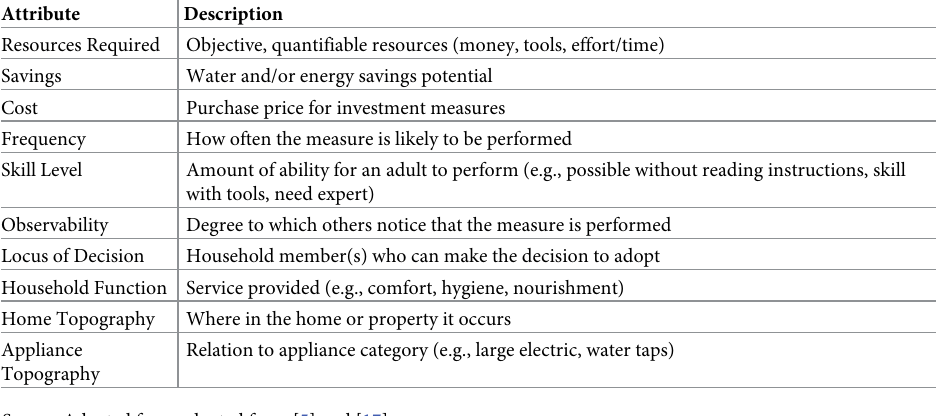
Observability Degree to which others notice that the measure is performed Locus of Decision Household member(s) who can make the decision to adopt Household Function Service provided (e.g., comfort, hygiene, nourishment) Home Topography Where in the home or property it occurs Appliance Relation to appliance category (e.g., large electric, water taps) Topography Source : Adapted from adapted from [5] and